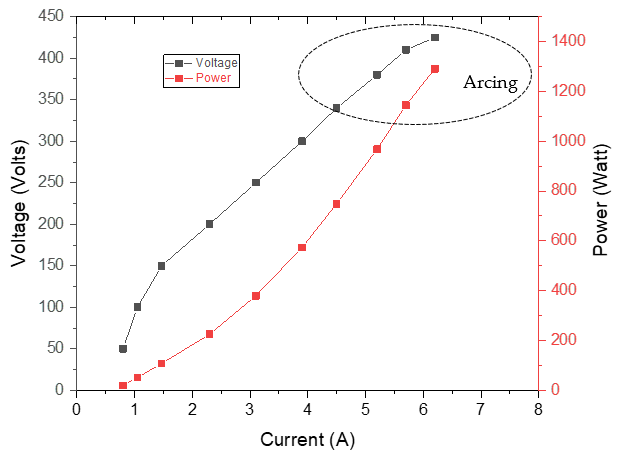
Figure 9. The discharge voltage and input power as a function of current at 30% O 2 gas rate, f = 13.56 MHz, and working pressure 0.3 Torr.